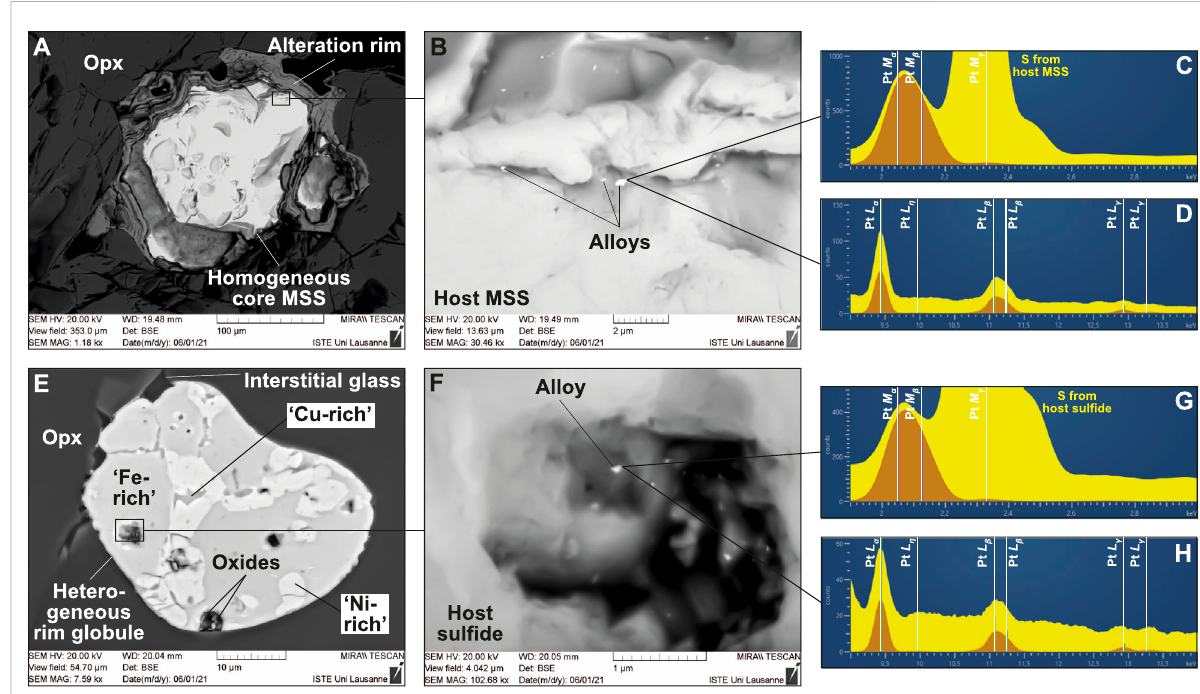
FIGURE 6 Ptalloys located on sul fi des from theglass-bearing, Type 1A veins from Kamchatkaand West Bismarck (SEM). BSE images of (A,B) a core sul fi de in the Kamchatka vein and (E,F) a rim sul fi de in the West Bismarck vein. The EDS spectra for those Pt alloys and their host sul fi des are respectively shown in (C,D) and (G,H) with peak identi fi cation. Note that Pt alloys can be found in association with (A) homogeneous sul fi des and (E) heterogeneous globules, respectively, ranging from “ Fe-rich ” (MSS) to “ Cu-rich ” ( “ xSS ” )